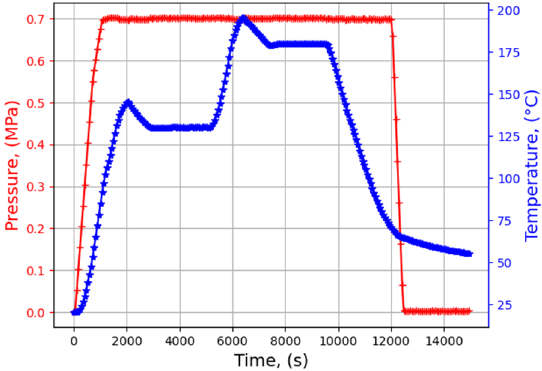
Figure 1. Thermal and pressure measurement during the curing cycle (pressure in red and tempera- ture in blue).